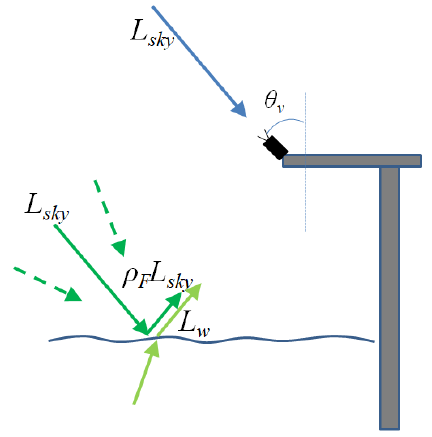
Figure 4. Instrument setup for L sky